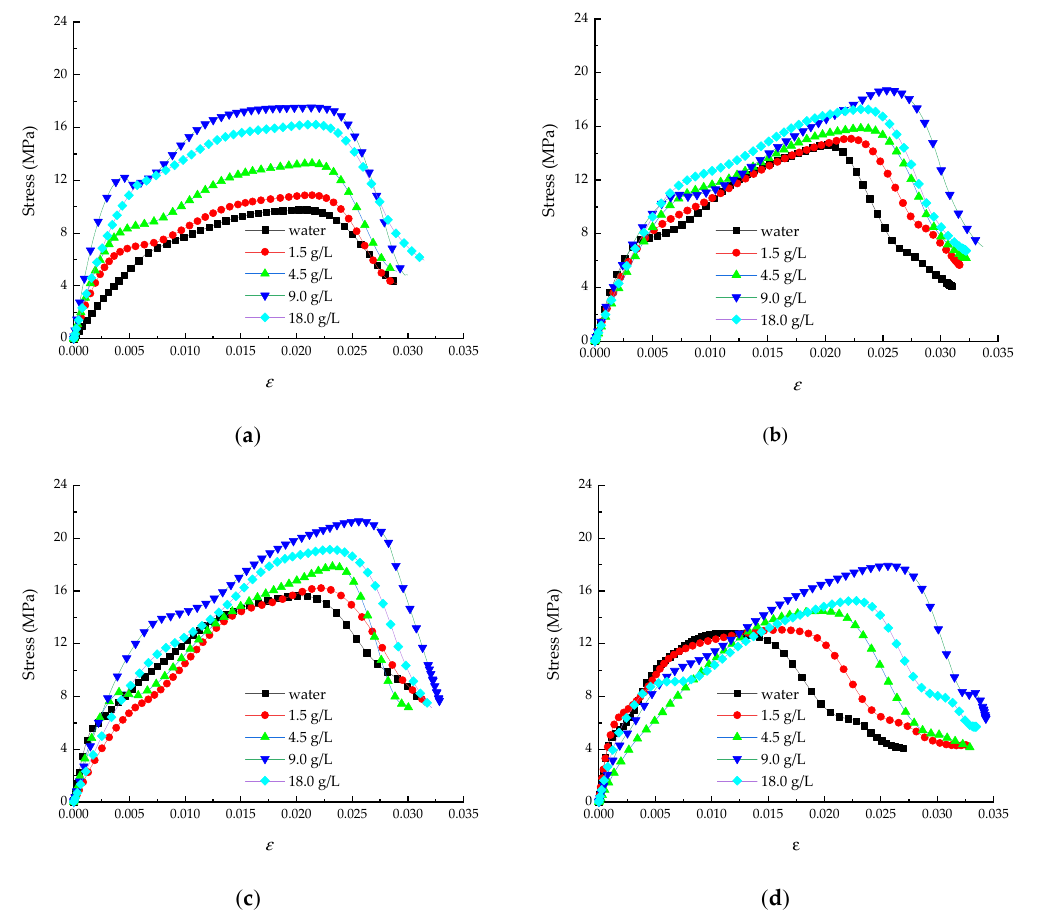
Figure 6. Stress–strain relationship curves of cement soil specimens under different Na 2 SO 4 solution concentrations: ( a ) curing period of 3 days; ( b ) curing period of 7 days; ( c ) curing period of 14 days; and ( d ) curing period of 28 days.